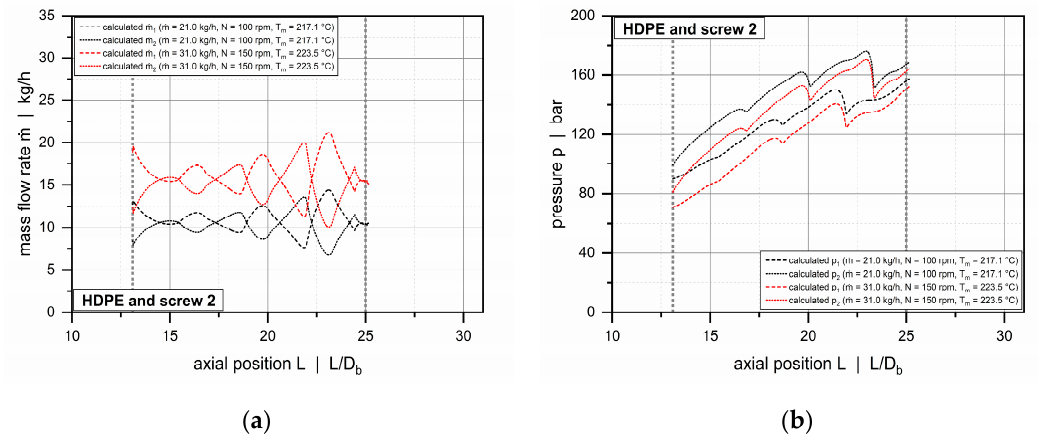
Figure 17. Distribution of mass-flow rates ( a ) and pressures ( b ) in subchannels 1 and 2 for barrel 1 (smooth-bore extruder) and screw 2. The dashed and dotted lines represent the solutions for subchannels 1 and 2, respectively.